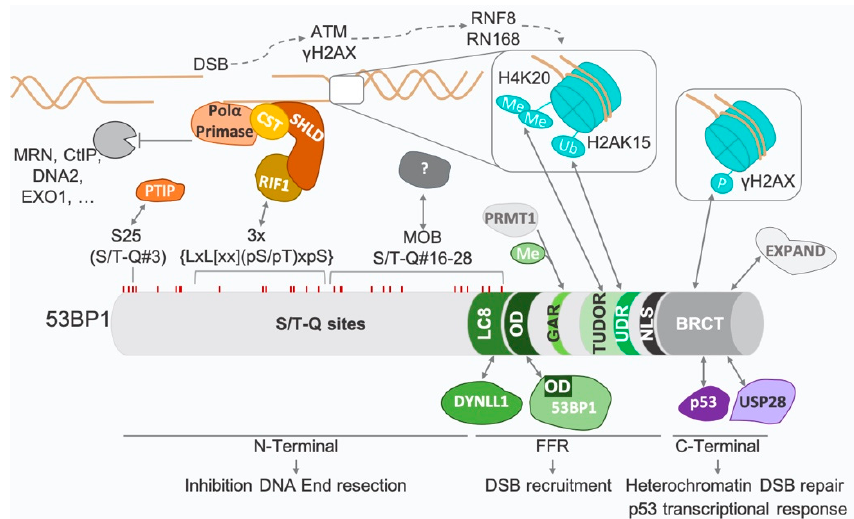
Figure 4. Domains and interactions of 53BP1. Upon DSBs, activation of ATM, unmasking of dimethylated lysine 20 of histone H4 (H4K20me2) and ubiquitination of histone H2A on lysine 15 of (H2AK15ub) by RNF168 and RNF8 allow the recruitment of 53BP1 to damaged chromatin. 53BP1 recruitment requires the focus-forming region (FFR), which includes the oligomerization domain (OD), the glycine-arginine rich motif (GAR), the tandem Tudor domain (TUDOR), the ubiquitin-dependent recognition motif (UDR), the dynein light chain-binding domain (LC8) and the nuclear localization sequence (NLS). DSB end resection is inhibited by RIF1, shieldin, CST, POL α and PRIMASE, which interact with the S/T-Q sites on the N-terminal part of 53BP1. RIF1 recognizes three consensus sequences, each containing two leucine and two S/T-Q sites (3x {LxL[xx](pS/pT)xpS}) [72]. Serine 25 (S25) allows the interaction of 53BP1with PTIP. The mobility domain (MOB) also encompasses S/T-Q sites and regulates DNA end mobility, but its interactors remain to be identified. The C-terminal part of 53BP1 contains two BRCA-carboxyterminal (BRCT) repeats, allowing 53BP1 interaction with p53, γ H2AX, EXPAND and USP28.